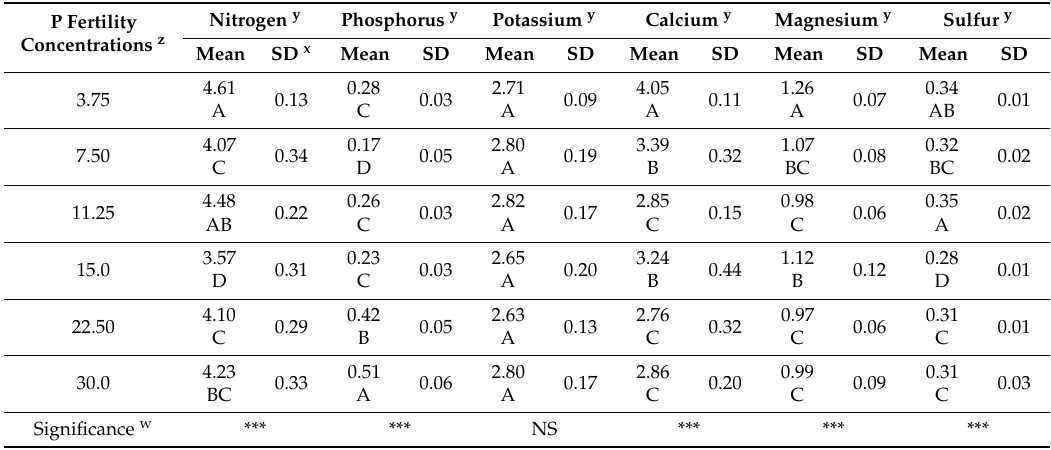
Figure 3. The impacts of phosphorus (P) fertility on P accumulation in leaf tissue of C. sativa “BaOx” after 8 weeks of vegetative growth. Graph displays means for each group of plants ( n = 10) with error bars representing standard deviations of data and the shaded blue representing the confidence region for the quadratic line of fit. Table 3. The impacts of phosphorus (P) fertility on macronutrient accumulation in leaf tissue of C. sativa “BaOx” after eight weeks of vegetative growth.